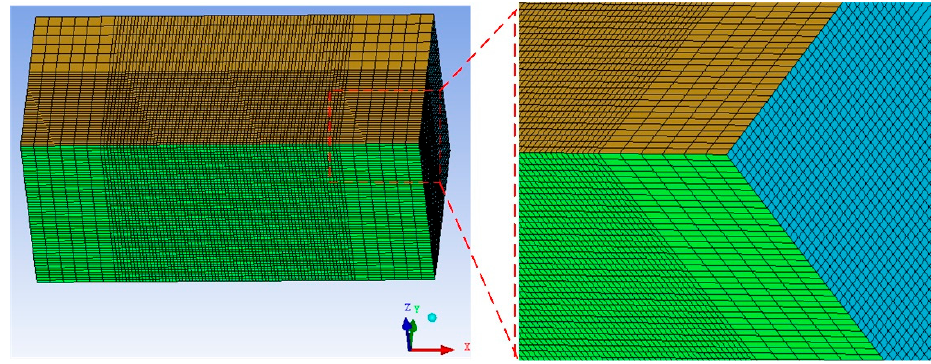
Figure 2. Model grid for simulation.